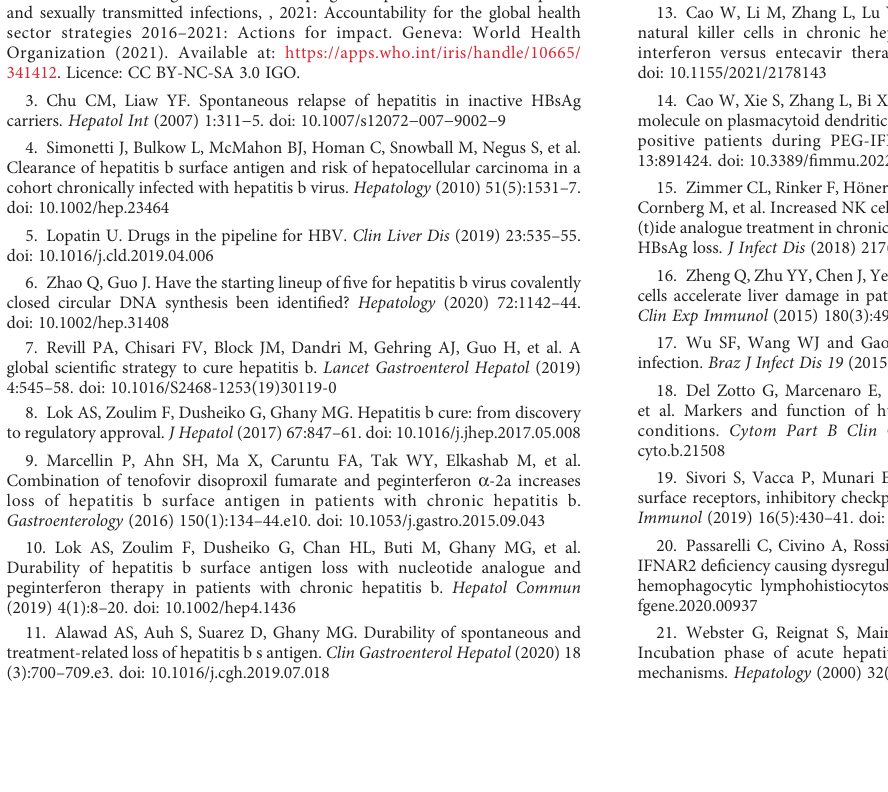
SUPPLEMENTARY FIGURE 1 Using FlowJo software for CD3-CD56+NK cell image analysis to illustrative dot plots related to the FACS